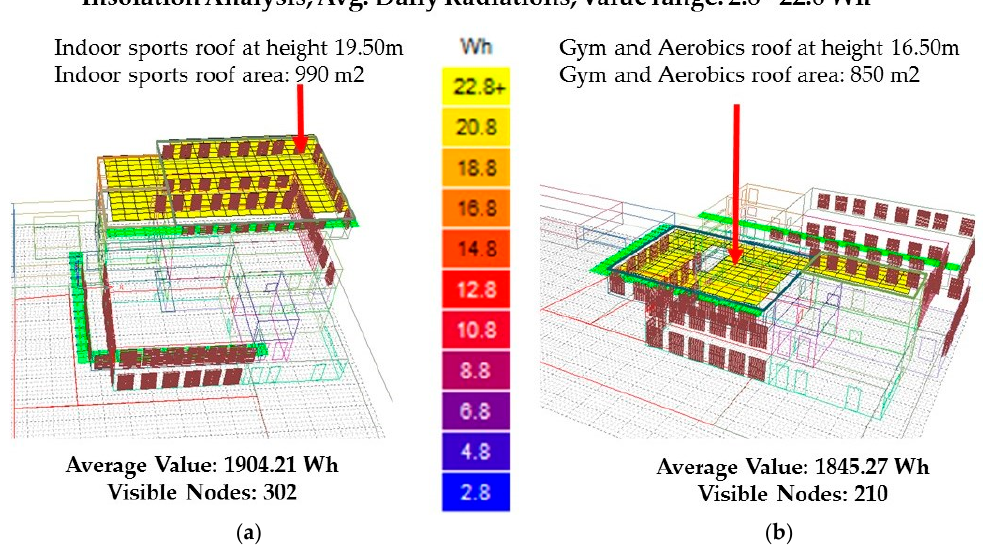
Figure 6. Solar access analysis on the building roof. ( a ) Analysis on the roof of the indoor games area; ( b ) analysis on the roof of the gym area.